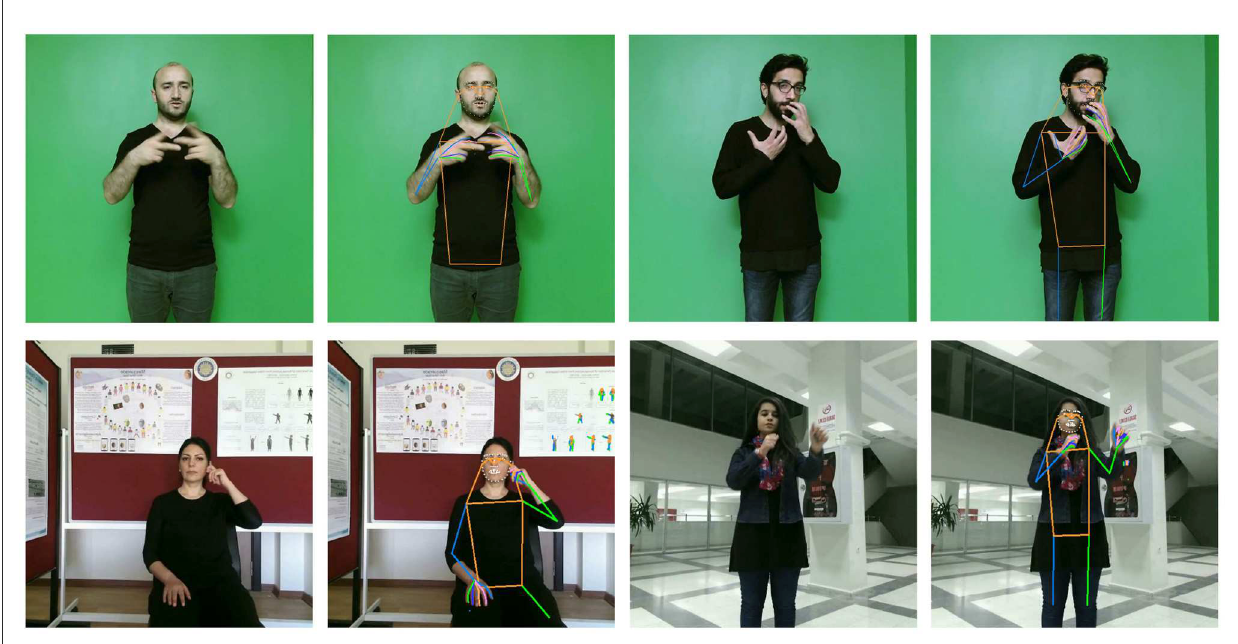
FIGURE3 Example frames from SL videos and pose estimation outputs from the BosphorusSign22k (top) and AUTSL (bottom) datasets.